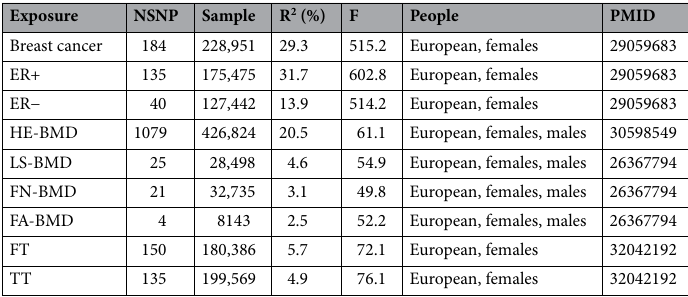
Table 1. Summary statistics of